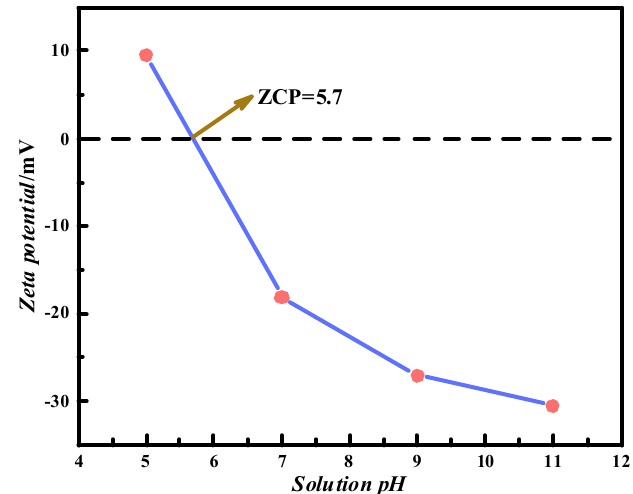
Figure 5. Zeta potential of nZVI@H at different pH levels.